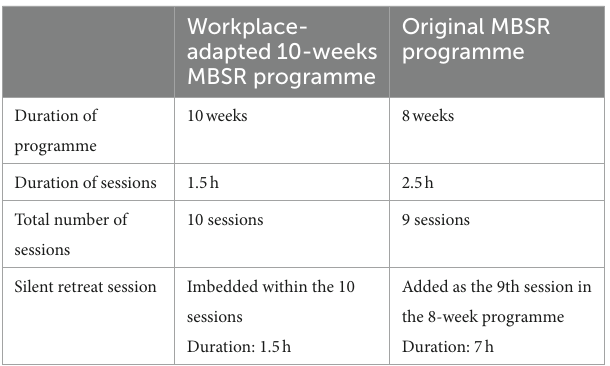
TABLE 1 Structural differences between the original MBSR programme and the workplace-adapted MBSR